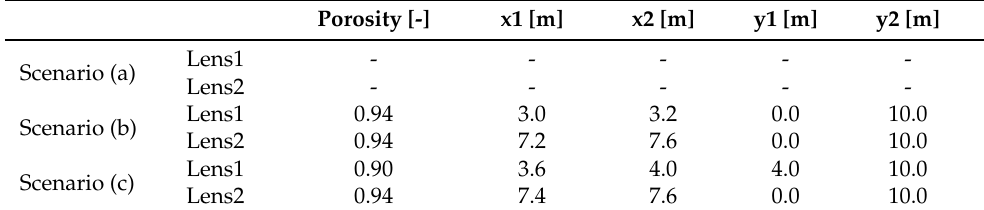
Table A1. Macropore parameters for the three implemented scenarios.